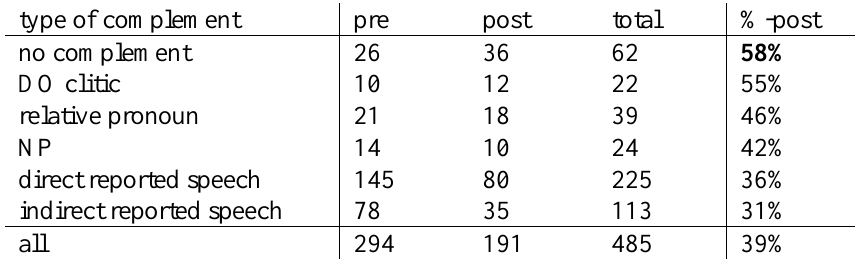
Table 6. Subject-verb inversion according to complement type of decir type of